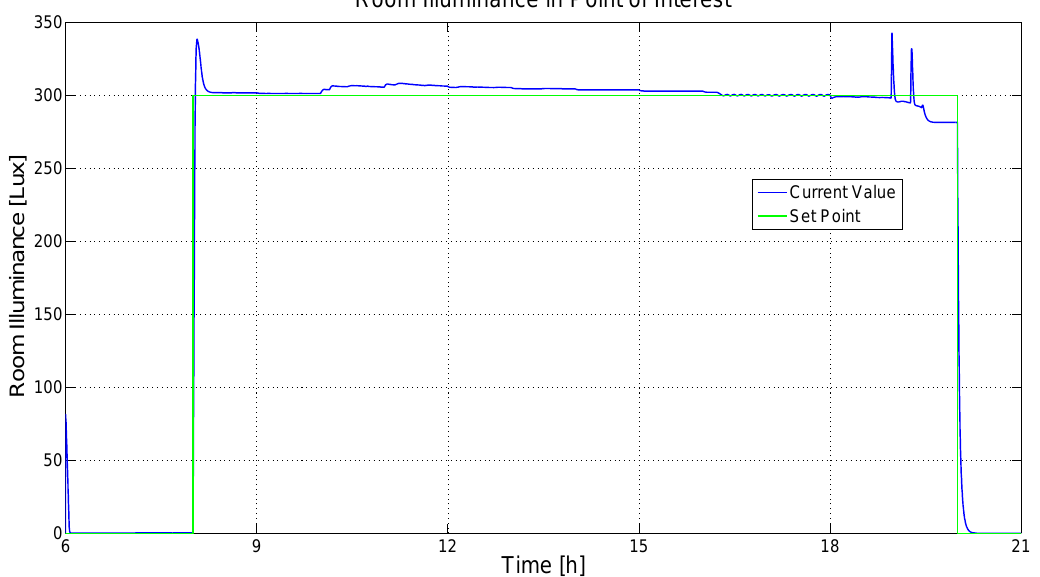
Figure 38. Control results (third scenario, modified control system, Comfort policy): MVs (heat pump, dimmer, and rolling shutters) and DV (presence of solar radiation).